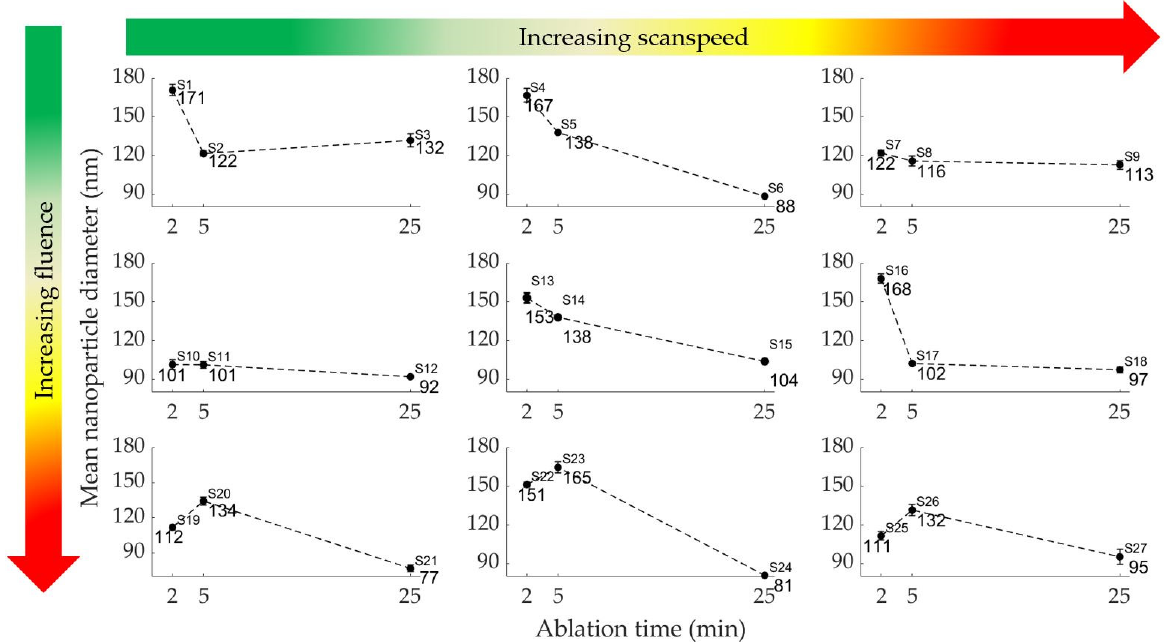
Figure 5. Effect of ablation time on nanoparticle mean diameter (nm).